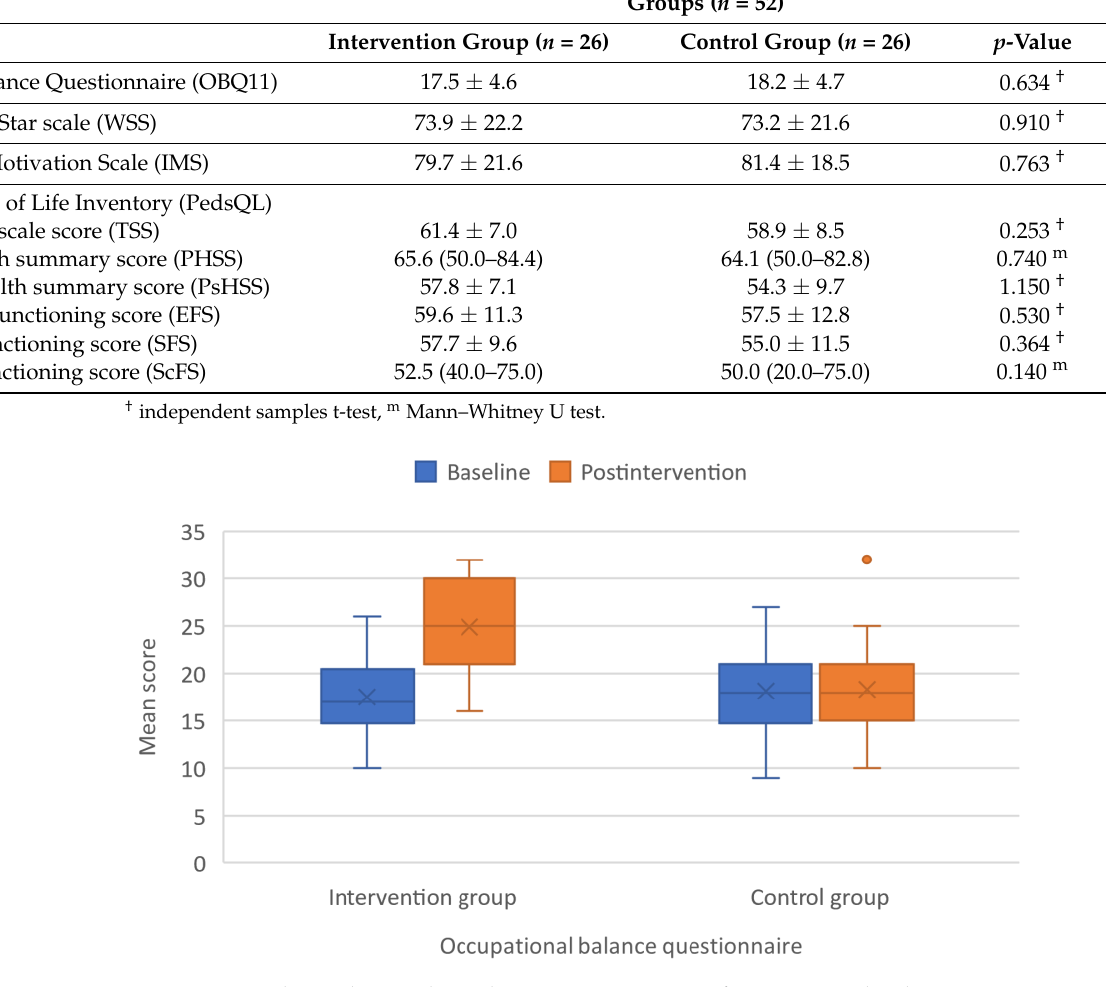
Figure 2. Boxplot with error bars showing mean scores of Occupational Balance Questionnaire (OBQ11) at baseline and after intervention.